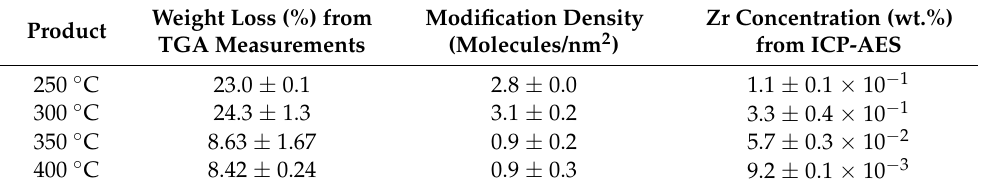
Figure 5. TGA curves obtained for PHA-modified nanoparticles synthesized at 250, 300, 350, and 400 °C under an air atmosphere and heating rate of 10 K/min. Table 1. The surface PHA modification density of the ZrO 2 nanoparticles and Zr concentrations of the nanoparticle dispersions.